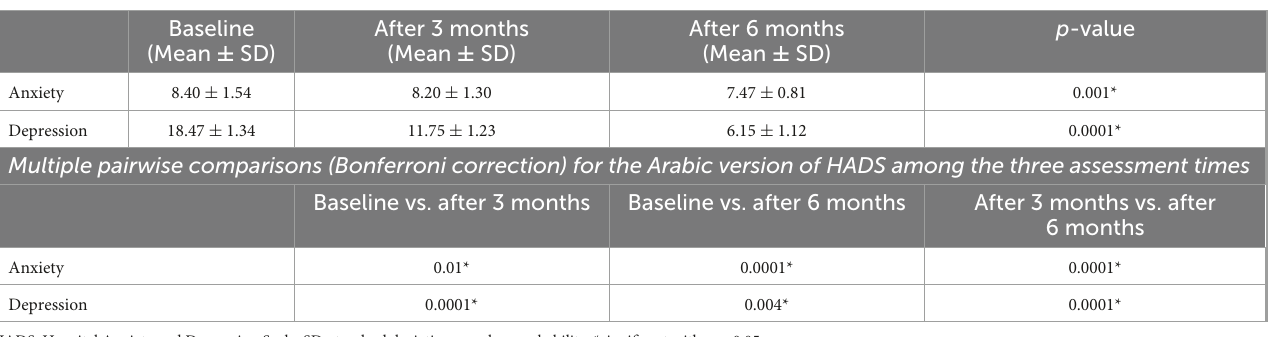
TABLE 4 Psychological function assessed by the Arabic version of HADS among the three assessment